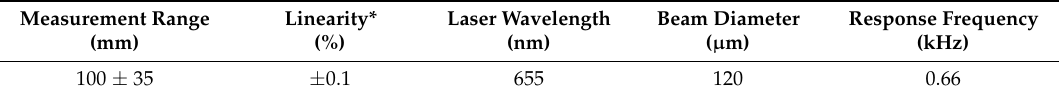
Table 2. Main parameters of the LTS.